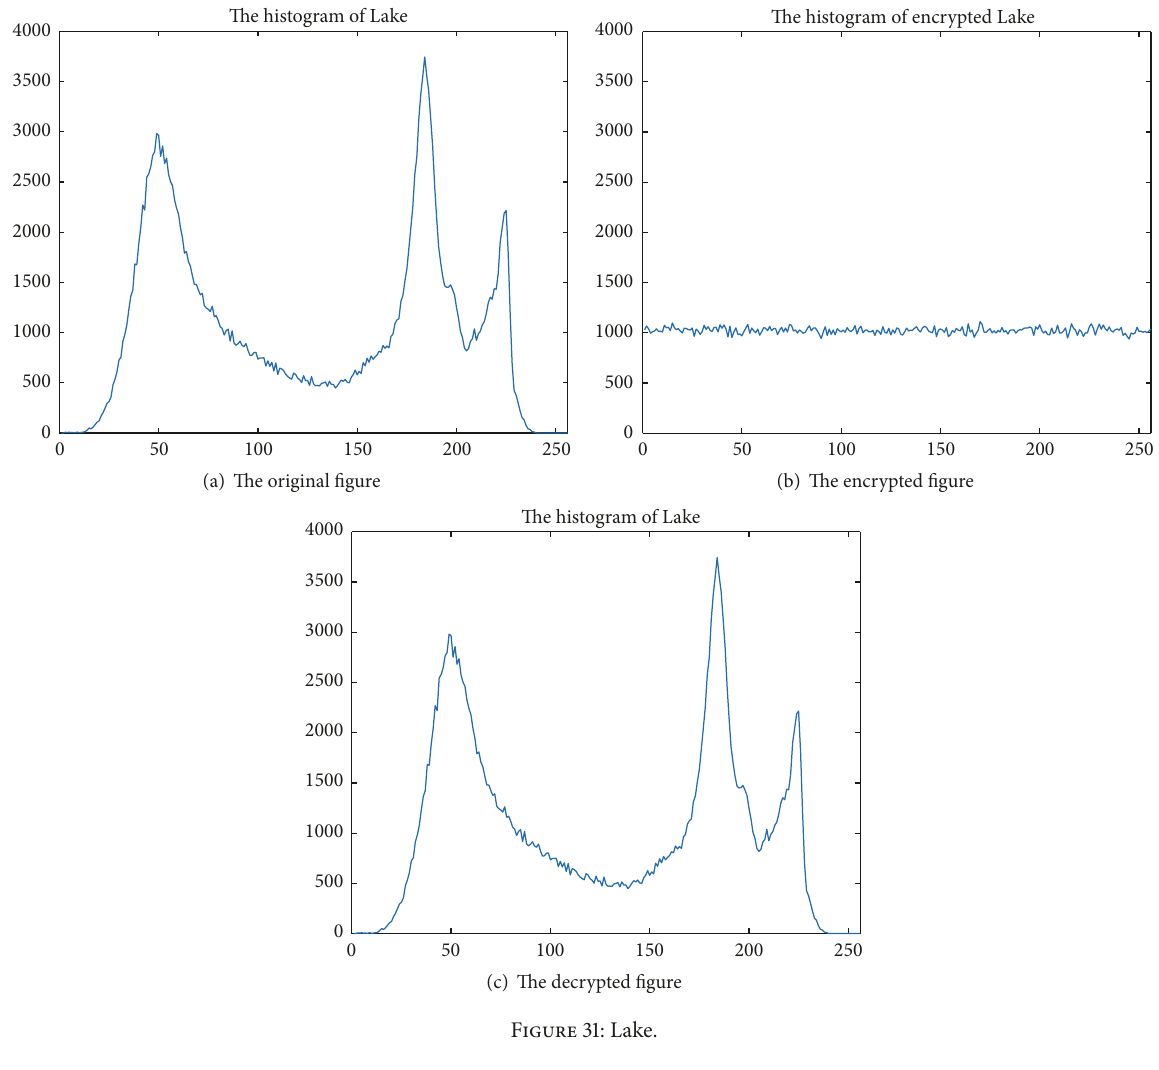
Table 7: NPCR and UACI between cipher-images with slightly different plain-images. Image